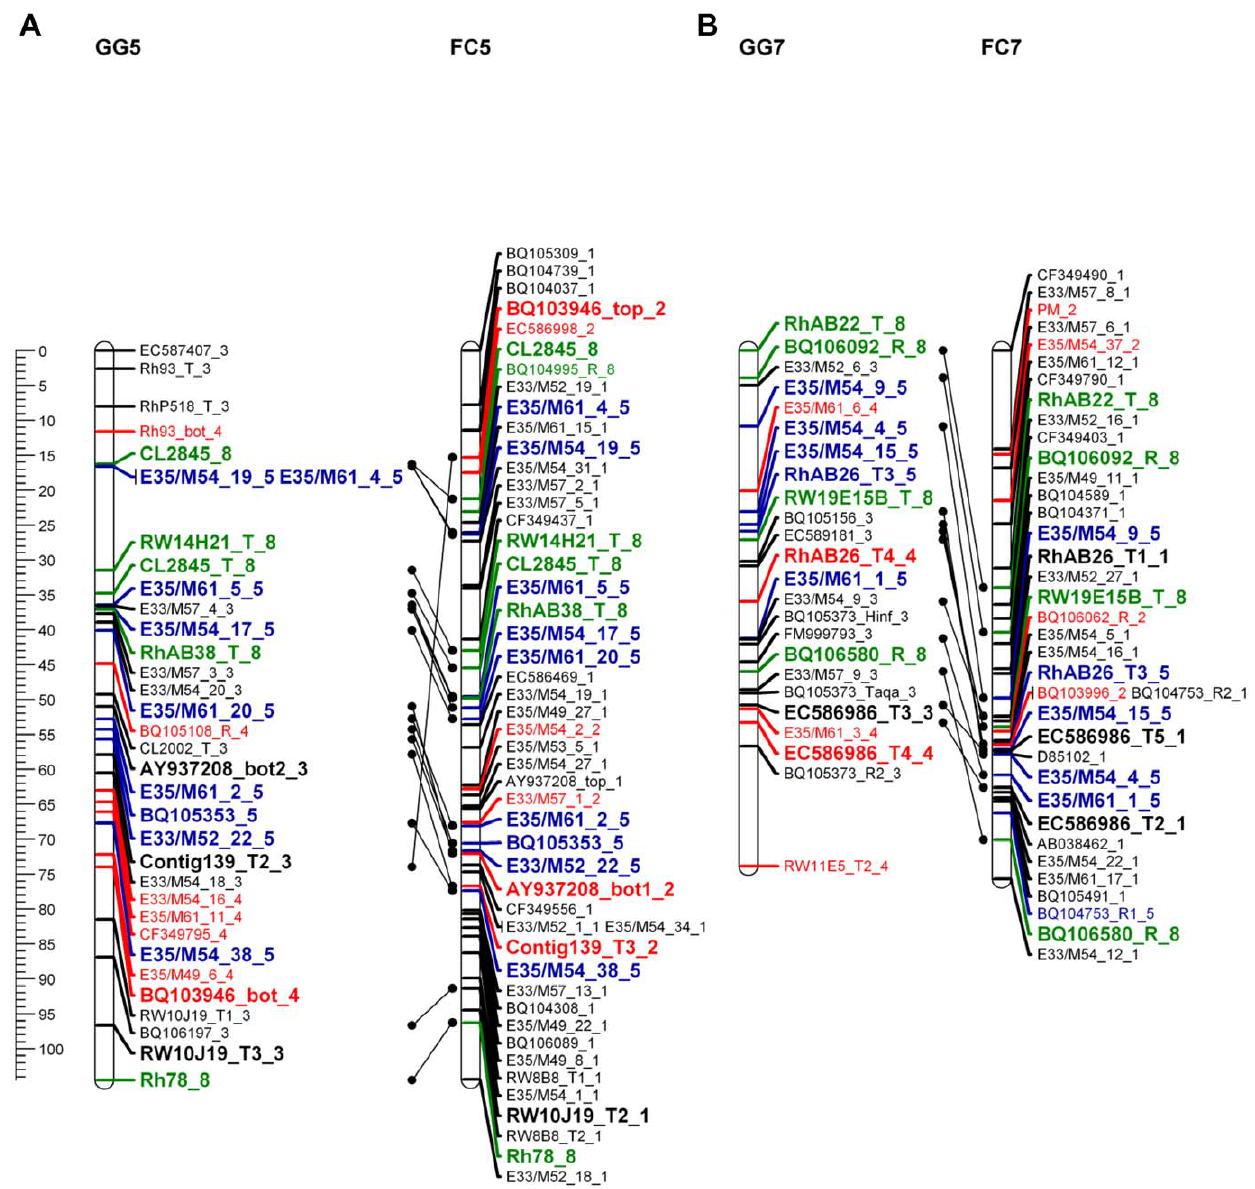
Figure 3. The linear order of common markers conserved in both parental maps . Each linkage group name contains the parental name and the linkage group number. Map distances are shown in cM as a ruler at the left page margin. Marker names indicated according to the nomenclature described in Table S1 . Each color represents a different segregation ratio (black for 1:1, red for 5:1, blue for 3:1 and green for codominant markers). Common markers are indicated in bold and larger font. A. Linkage group 5. B . Linkage group 7. The remaining linkage groups are presented in Fig. S5.